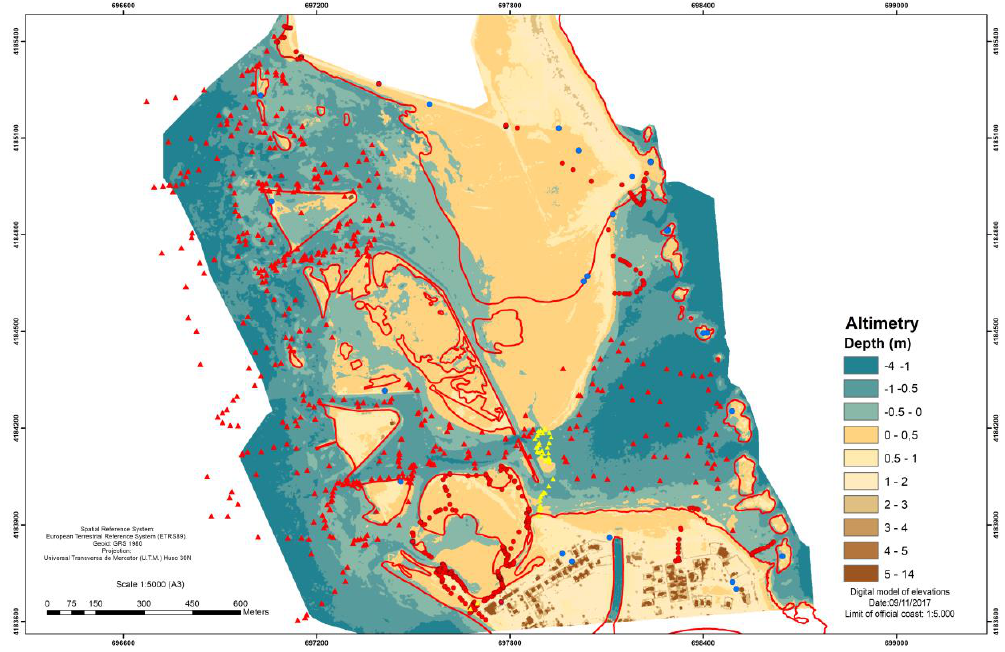
Figure 13. Water depth determined using the USV and the Pleiades images of 11 November 2017, as well as ground data (red and blue points correspond to GPS data, while yellow points to USV data). The red line corresponds to the coast in 1999.